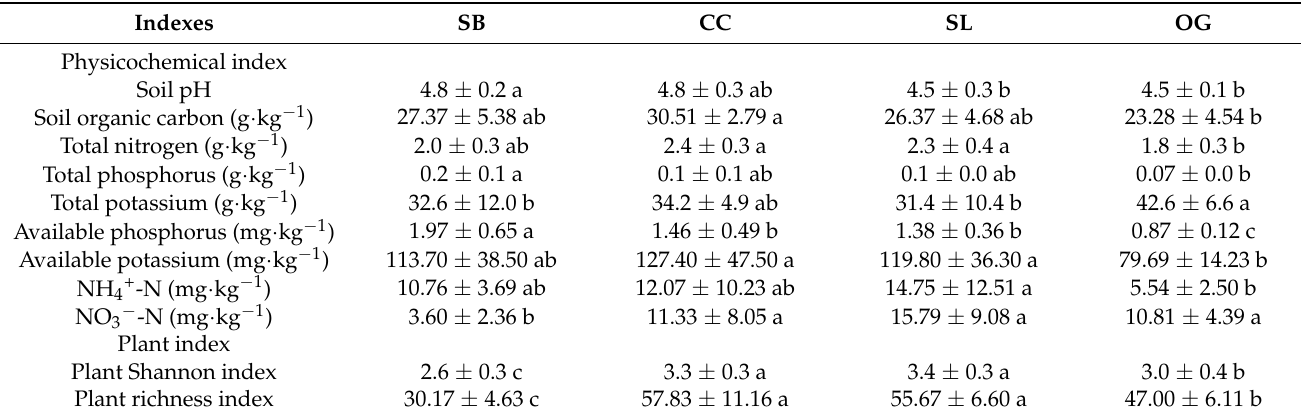
Table A2. Comparison of physicochemical and plant indexes in the four forest stands.